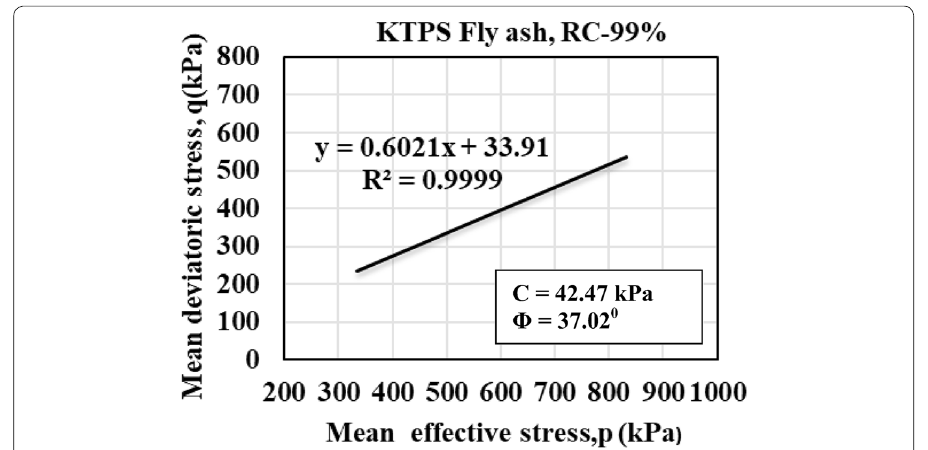
Fig. 22 p–q diagram of KTPS fly ash at RC-99%